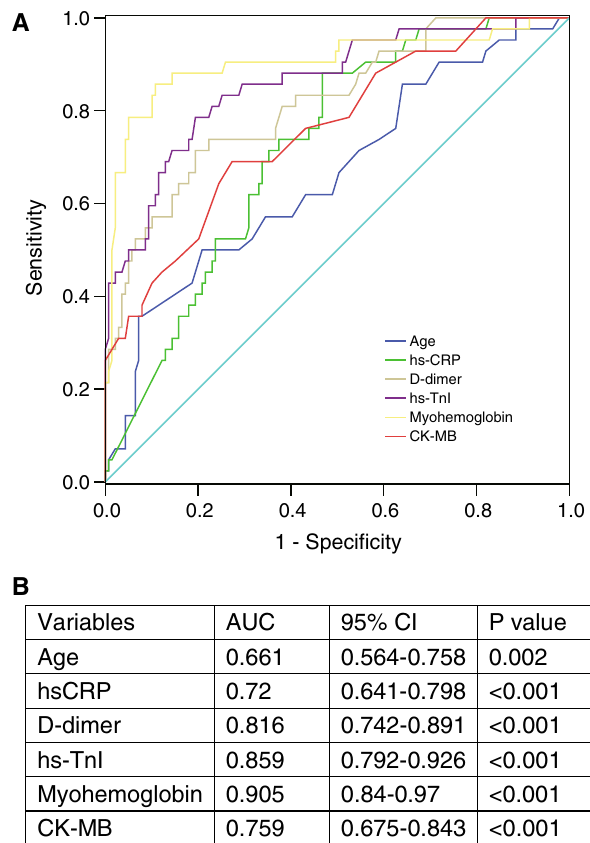
Figure 2. Receiver operating characteristic (ROC) analysis of the prediction of in-hospital mortality. ( A ) ROC curve of age and laboratory biomarkers. ( B ) Area under the ROC curve (AUC) with 95% confidence interval (CI) of each variable. CK-MB, creatine kinase-myocardial band; hs-TnI, high sensitivity-cardiac troponin I; hs-CRP, high-sensitivity C-reactive protein.